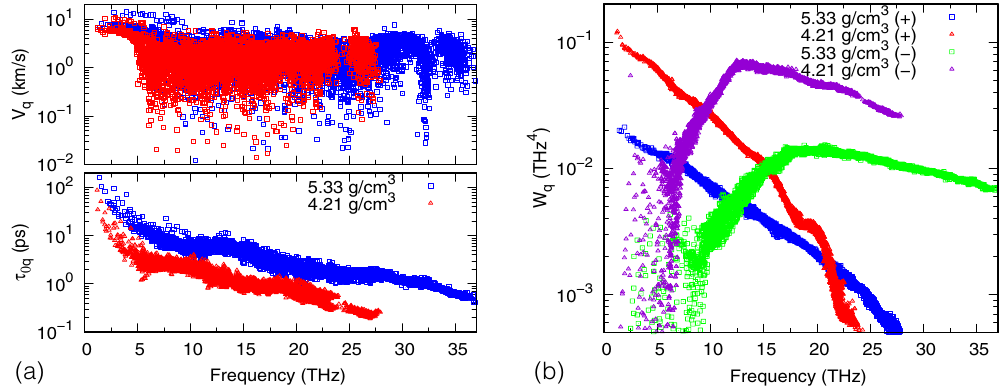
Figure 3. ( a ) Group velocity v q and anharmonic lifetime τ 0 q ( b ) Weighted phase space W q versus phonon frequency at 300 K.